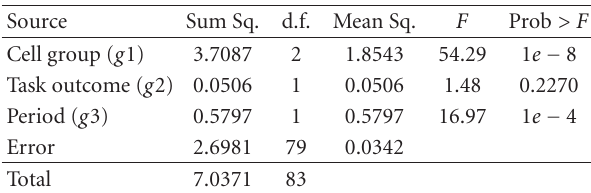
Table 4: Summary of multiway